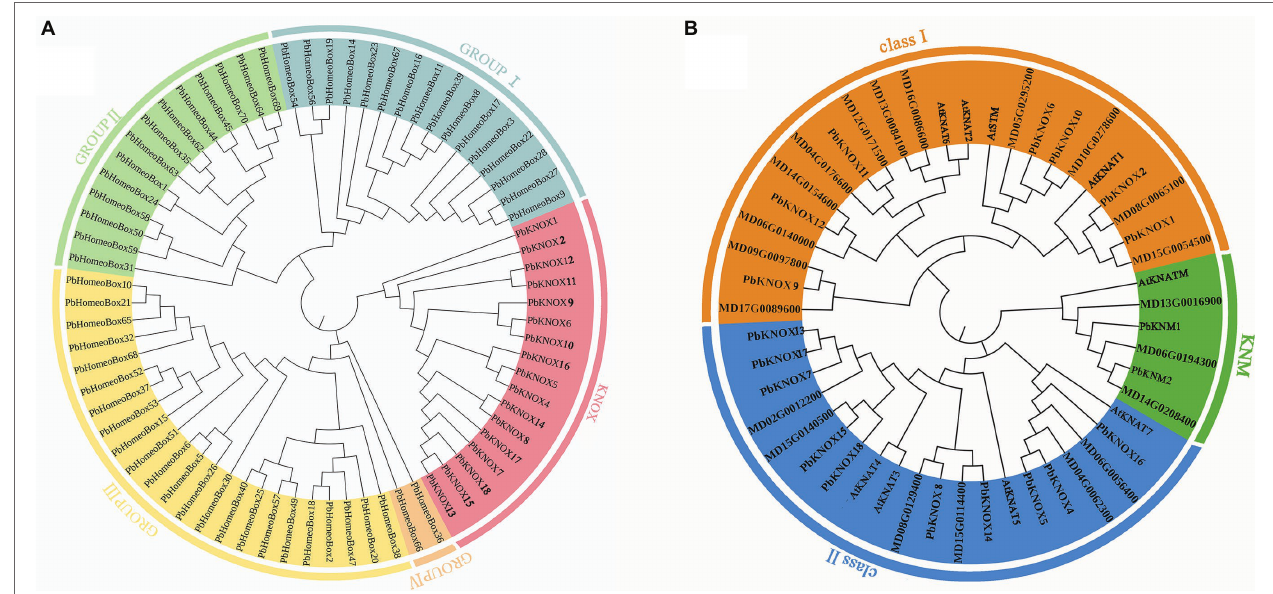
FIGURE 1 | Phylogenetic tree constructed with the neighbor-joining method using homeobox TF domains in Pyrus bretschneideri (A) and KNOX TF domains in Pyrus bretschneideri , Malus domestica , and Arabidopsis (B) . The tree was divided into three groups (class I, class II, and